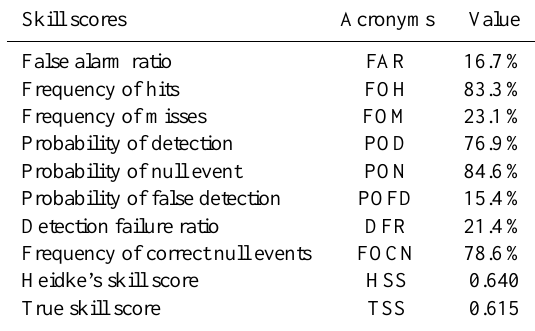
Table 10. Skill scores for verification contingency table. Calcula- tion follows method of López and Sánchez